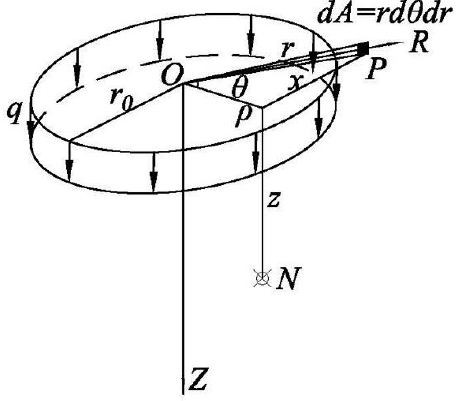
Figure 2. Calculation diagram of the vertical stress exerted by a uniformly distributed load.